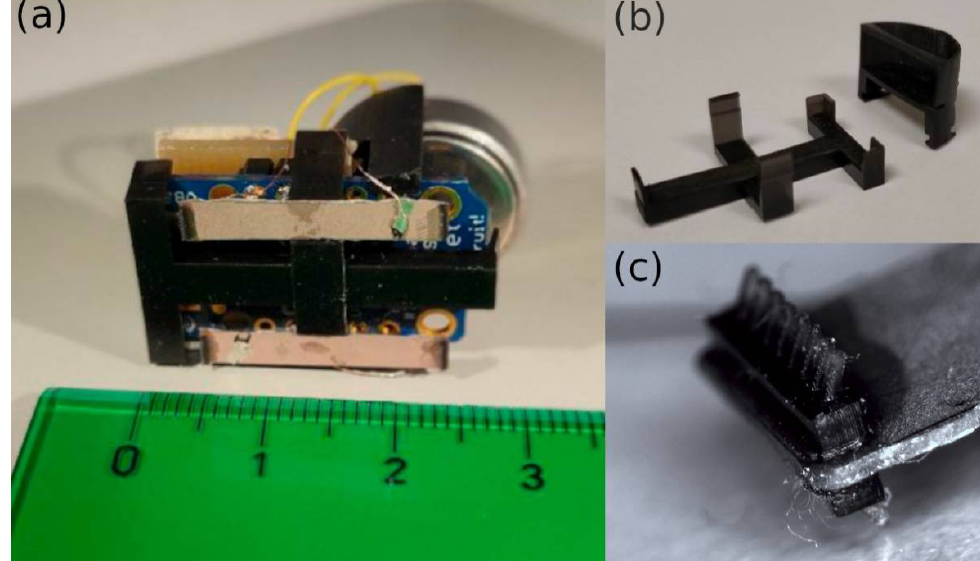
Figure 8. ( a ) Bottom view of the fully assembled robot. ( b ) 3D-printed supporting structure. ( c ) De- tailed view of the legs on one of the edges of the PZT plate. tailed view of the legs on one of the edges of the PZT plate.